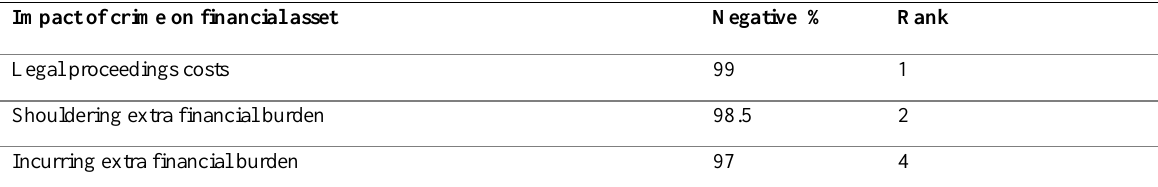
Table 5: Impact of crime on financial asset